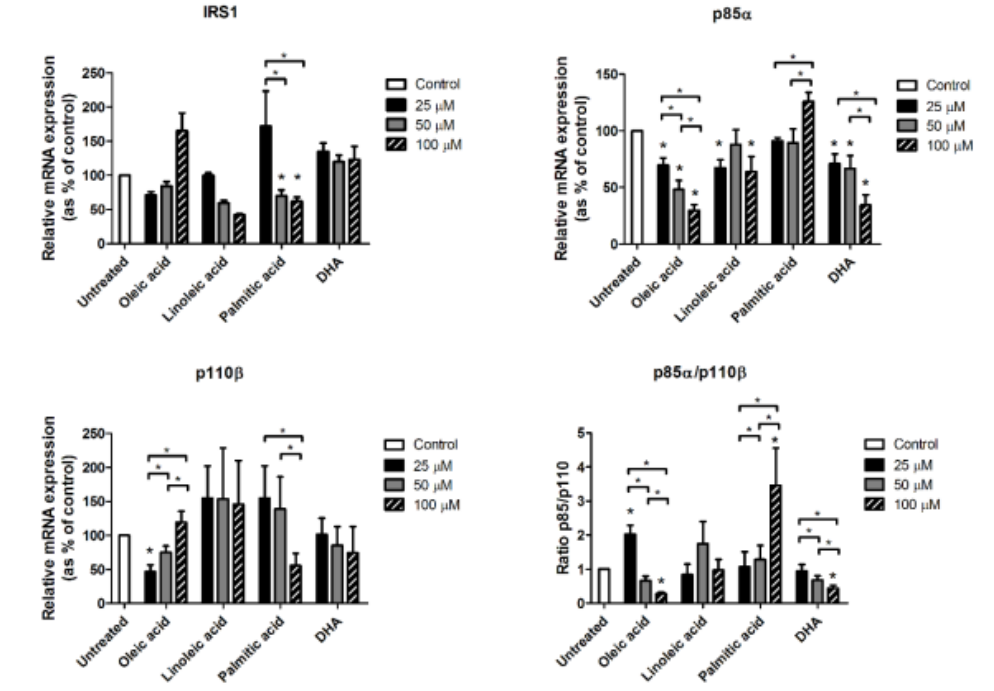
Figure 2. mRNA expression levels of IRS1, p85 α , p110 β and p85 α / p110 β ratio from isolated visceral adipocytes incubated with oleic, linoleic, palmitic and dosahexaenoic (DHA) acids. For each fatty acid, incubations were made with 25, 50 and 100 µ M dose. Gene expression was assessed using the 2 - ∆∆ Ct method, which was converted as % of control (untreated). Results are represented as mean ± SEM. * p < 0.05 comparing each treatment and dose to the untreated sample (stars over bars) and between di ff erent doses inside each treatment